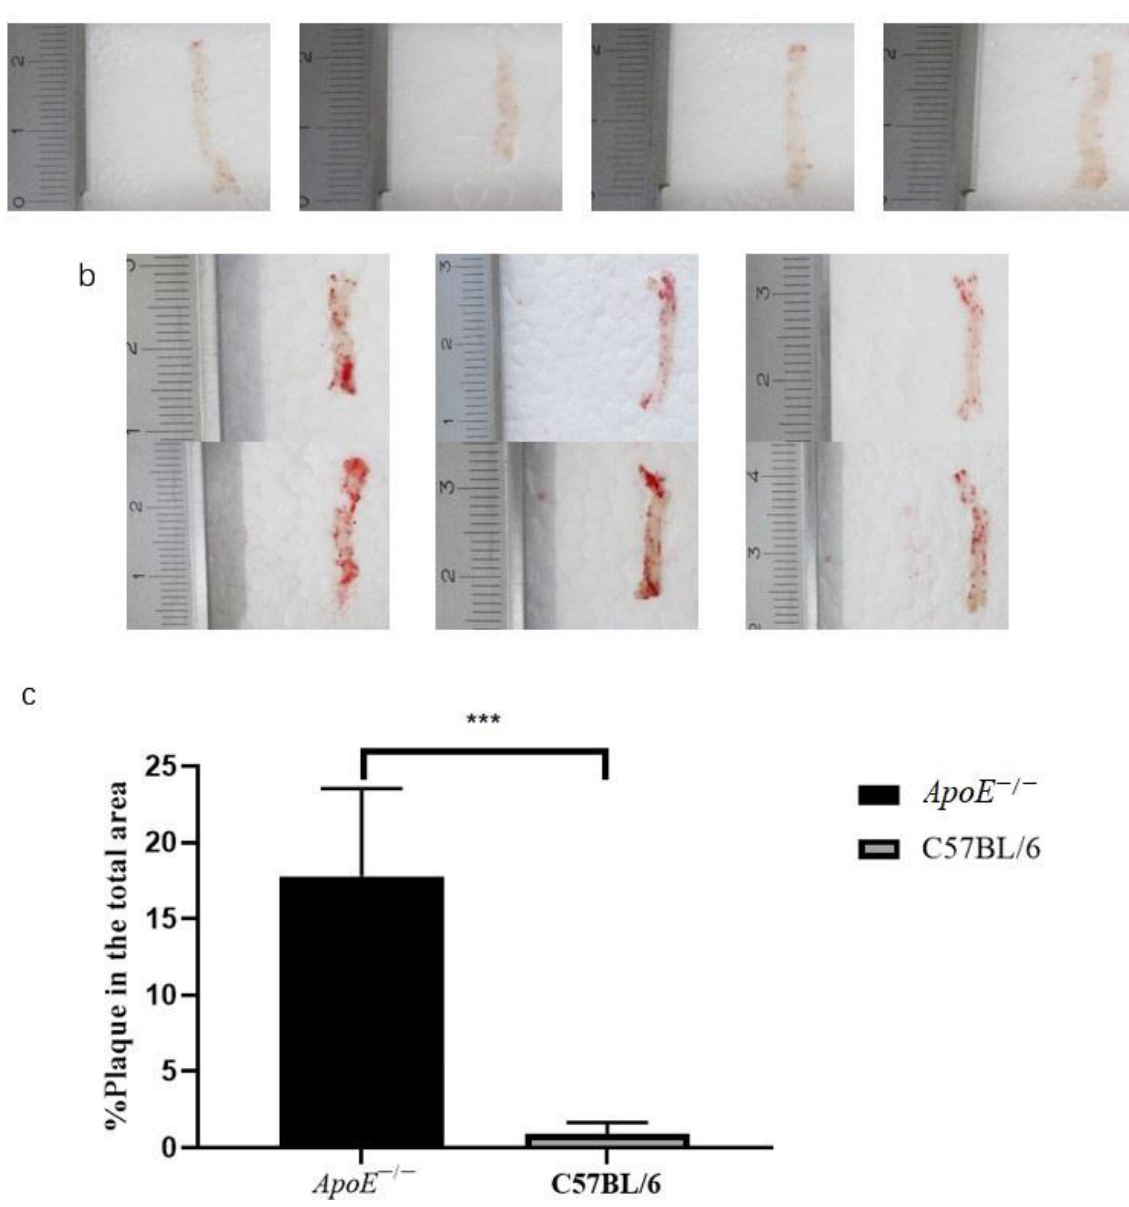
Figure 2. Results and quantitative analysis of oil red O staining of the whole aorta in the ( a ) control group and ( b ) experimental group, and ( c ) comparison of the staining area ratio, ***, p < 0.001.